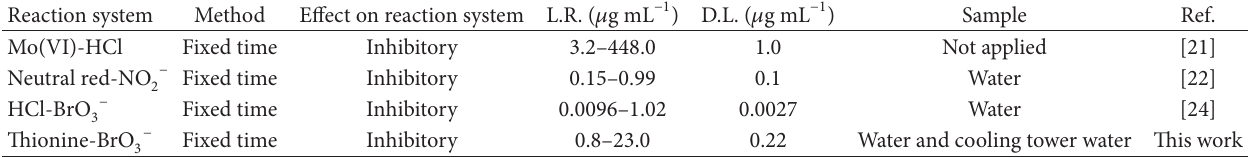
T 2: Comparison of some analytical parameters of catalytic spectrophotometric methods to proposed method. Reaction system